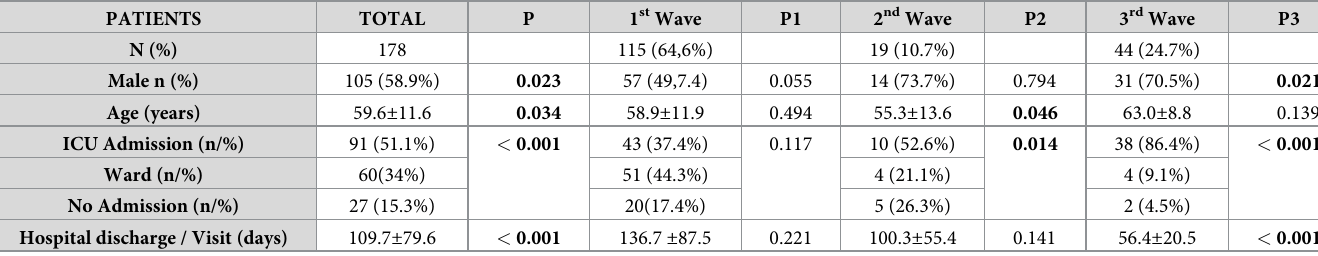
Table 1. General characteristics of patients according to the three pandemic waves analysed.